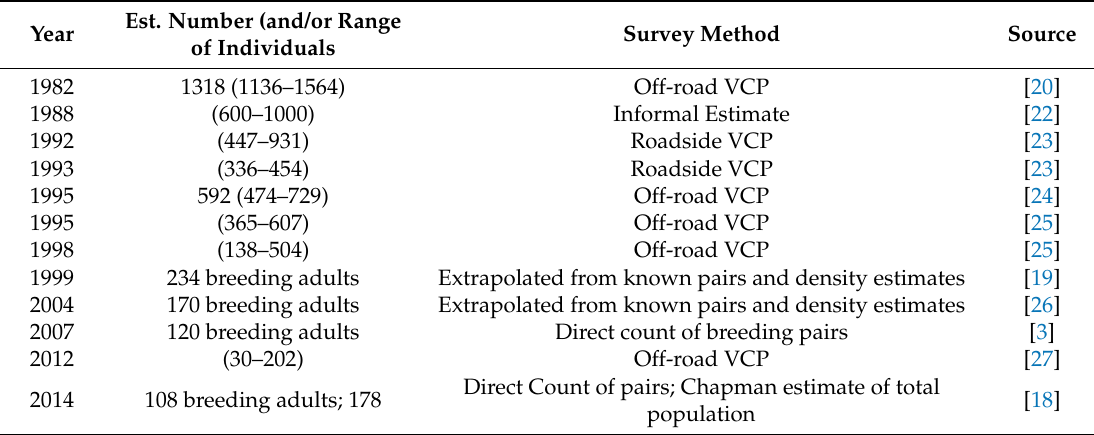
Table 1. Summary of results of Mariana Crow surveys on Rota since 1982. [Modified from Table 1 in the Revised Recovery Plan for the Mariana Crow [16]]. Variable circular plot is abbreviated as